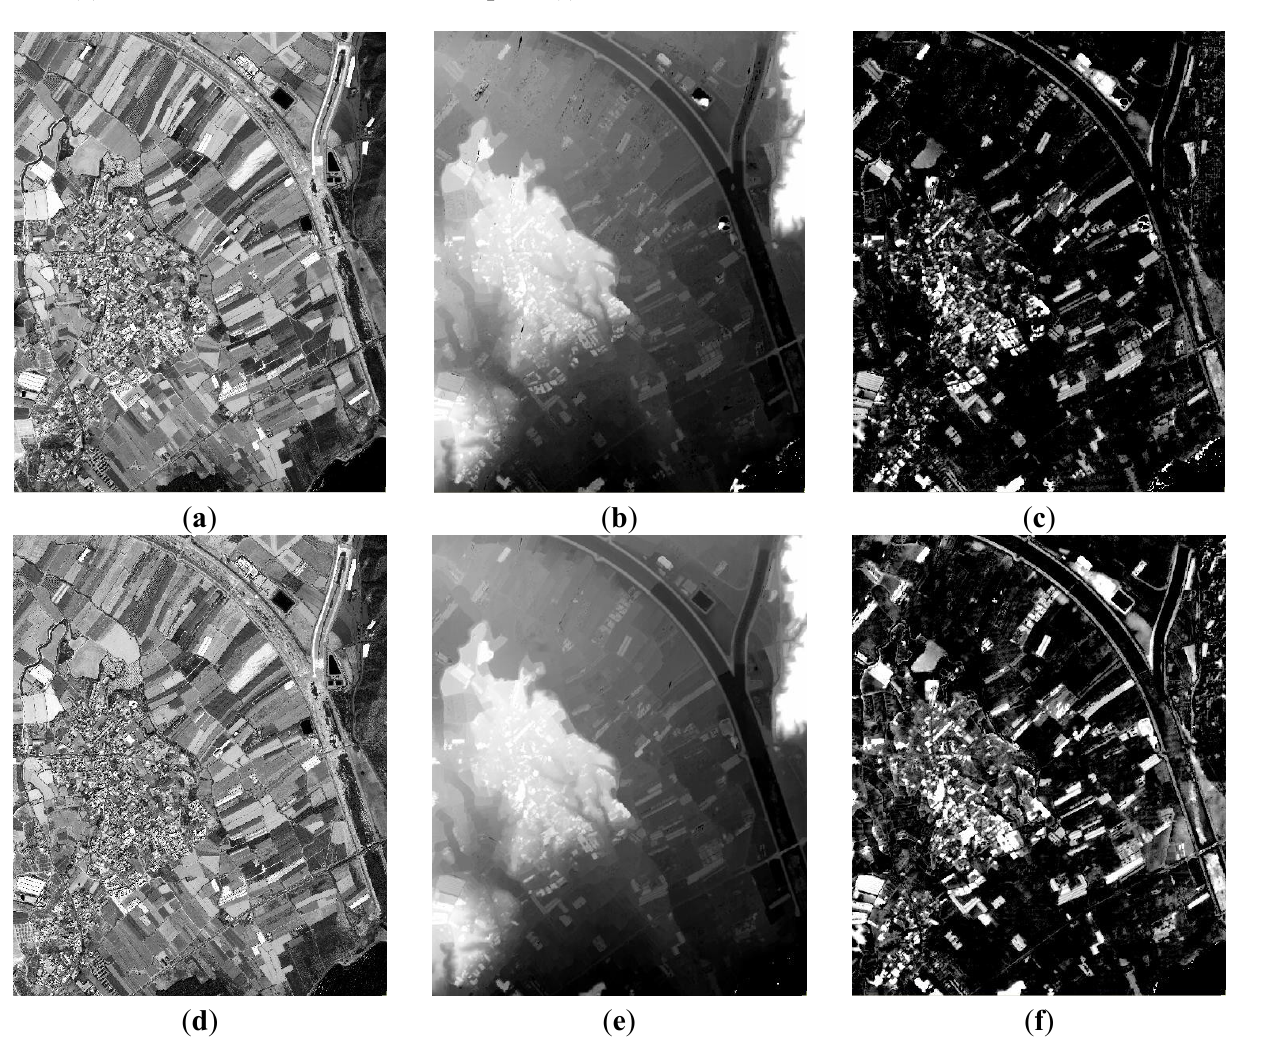
Figure 2. ( a ) PAN orthoimage from WV10; ( b ) DSM from WV2 stereo pair; ( c ) nDSM by subtracting the Andalusia DEM from the WV2 derived DSM; ( d ) PAN orthoimage from